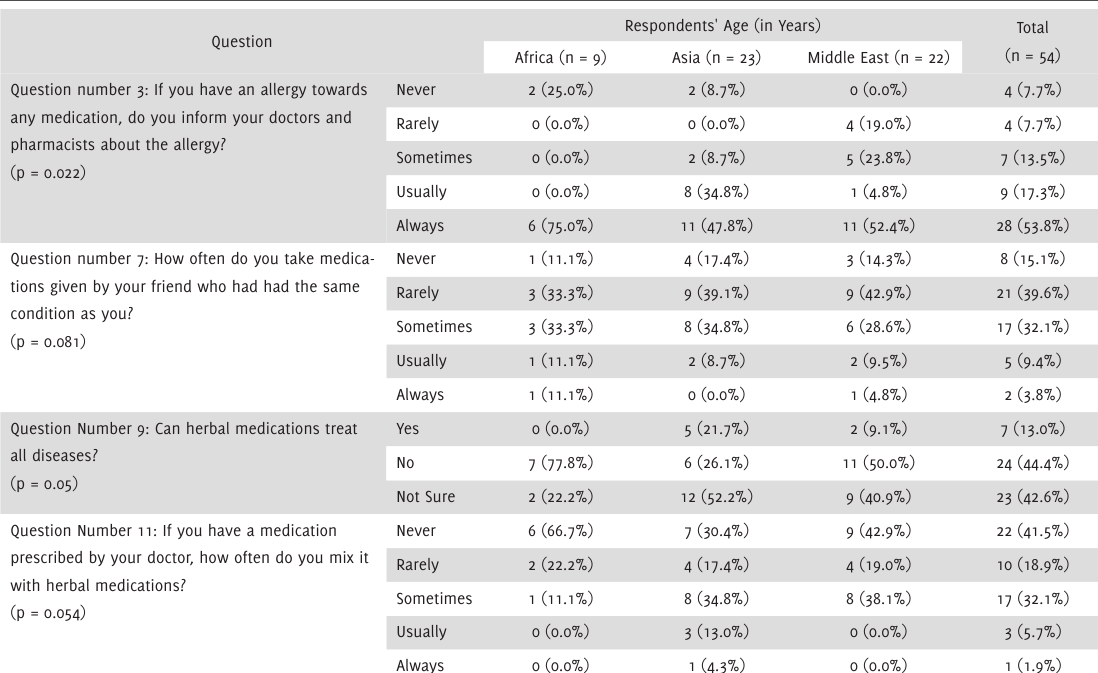
Table 2. Students’ Responses to Questions 3, 7, 9, and 11 According to Their Regions of